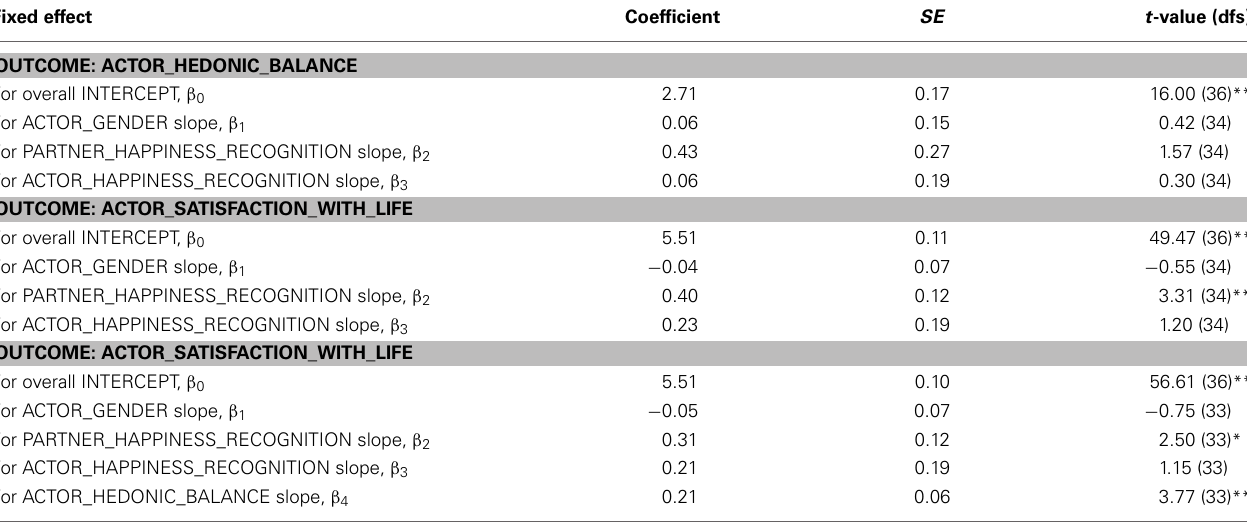
Table 2 | Parameter estimates for the HLM analyses predicting an actor’s hedonic balance and life satisfaction from his/her partner’s proficiency in identifying positive emotions in Study